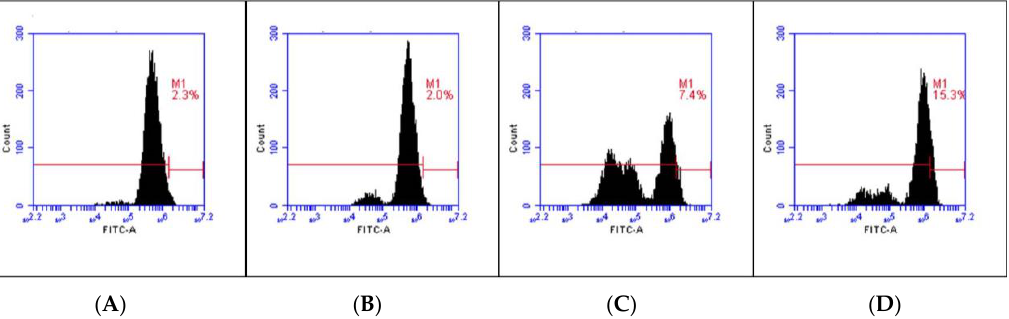
Figure 6. ROS generation in ( A ) untreated A549 cells (B) A549 cells treated with 50 µg/mL C.